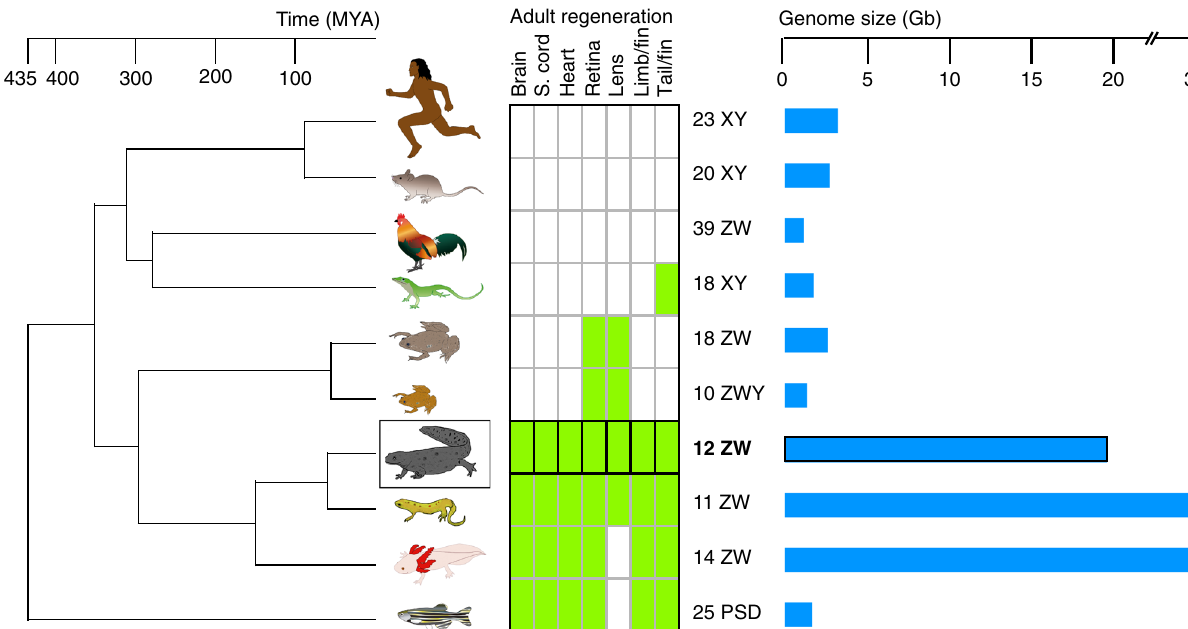
Fig. 1 The Iberian ribbed newt P . waltl is a prime model for adult regeneration. Compared to other research animal models, P . waltl is the most regenerative adult vertebrate amenable to laboratory breeding. Phylogenetic tree from TimeTree 66 . Regeneration capacities based on 6, 13,67 – 70 . Sex chromosomes from refs. 71 – 74 . Genome sizes from https://www.ncbi.nlm.nih.gov/genome/ (summed from Size (Mb)